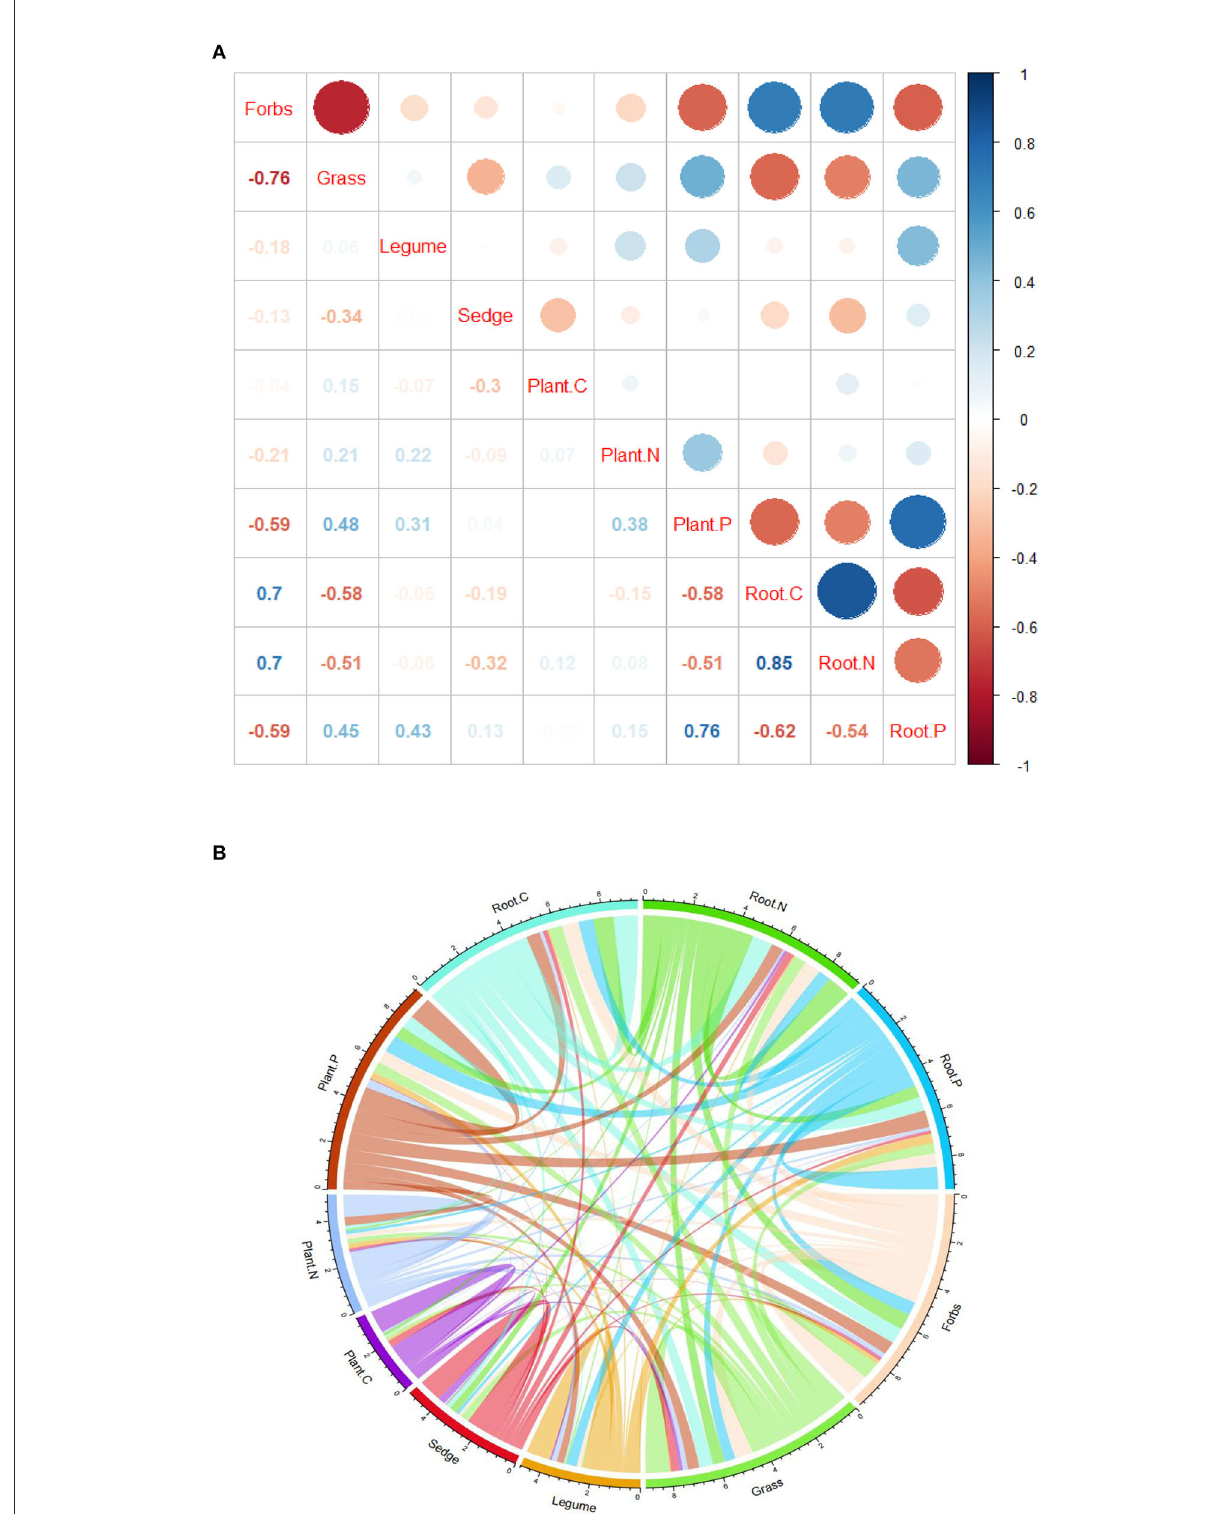
FIGURE4 Correlations between PFGs with plant C, N, and P and root C, N, and P. (A) Red is negative, and blue is positive. The size of the circle represents the strength of the correlation. (B) The line thickness indicates the strength of the